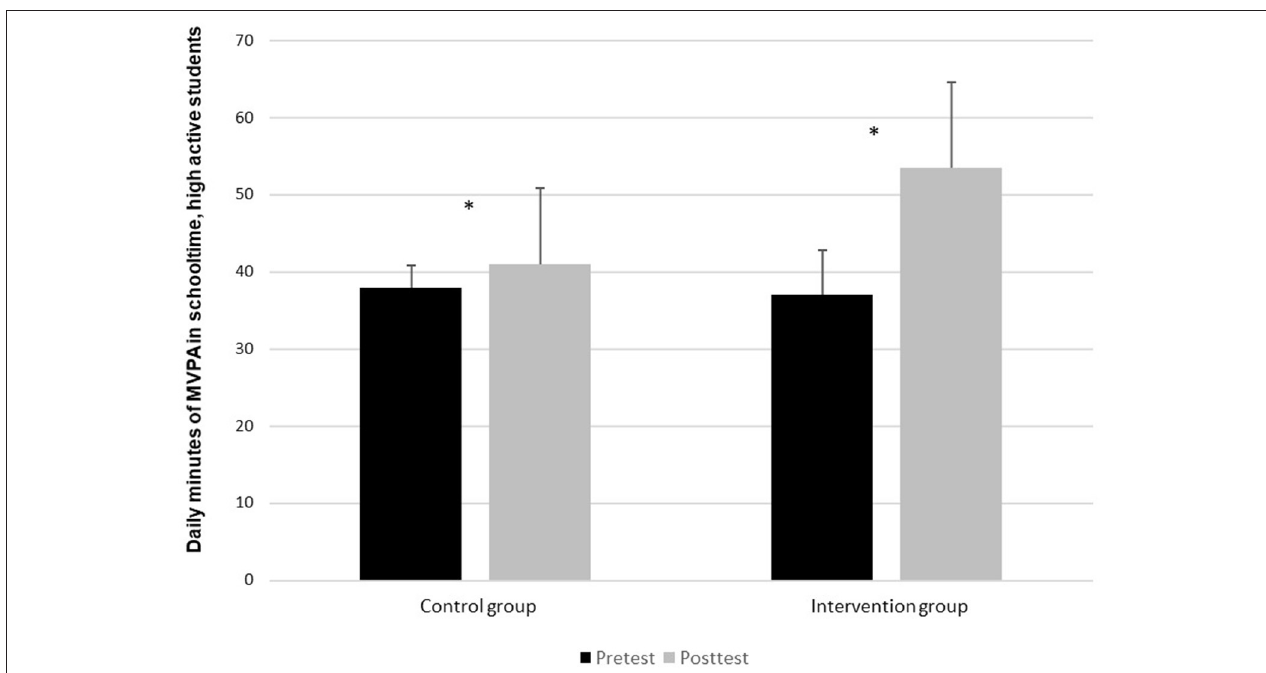
FIGURE 4 | Daily contribution of MVPA in schooltime for pupils in the high-active group, pre-test and post-test.*Indicates a significant difference ( p < 0.05) between pre-test and post-test in the daily MVPA in schooltime of the intervention